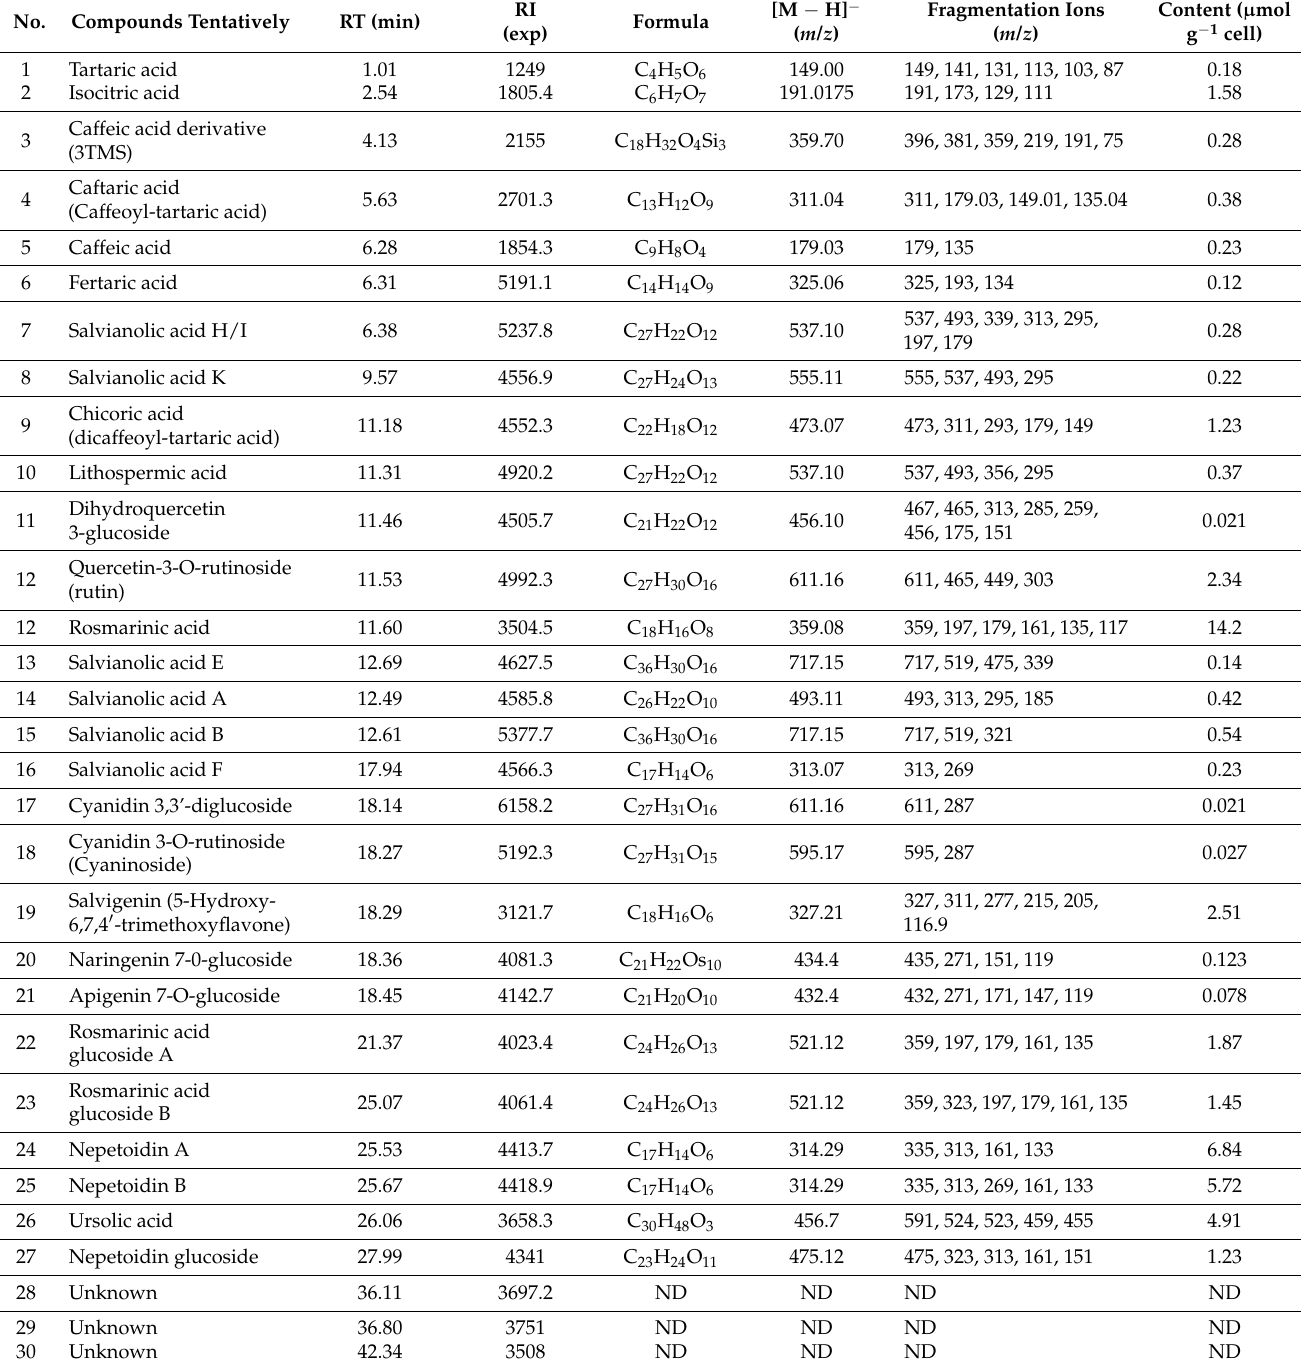
Table 2. Chemical composition of secondary metabolites, polyphenolic acids, and flavonoids detected from the cell suspensions of O. basilicum by Waters Acquity UPLC –I class coupled with Xevo TQD MS negative